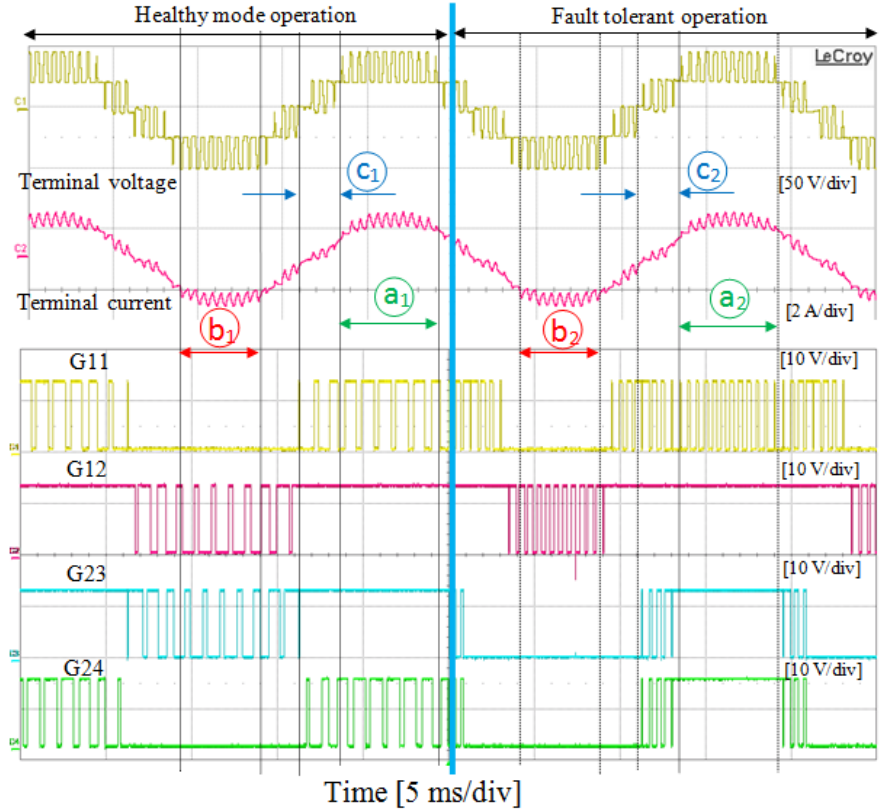
Figure 15. Detailed experimental results of the fault-tolerant strategy in the case of blowing fuse F4.